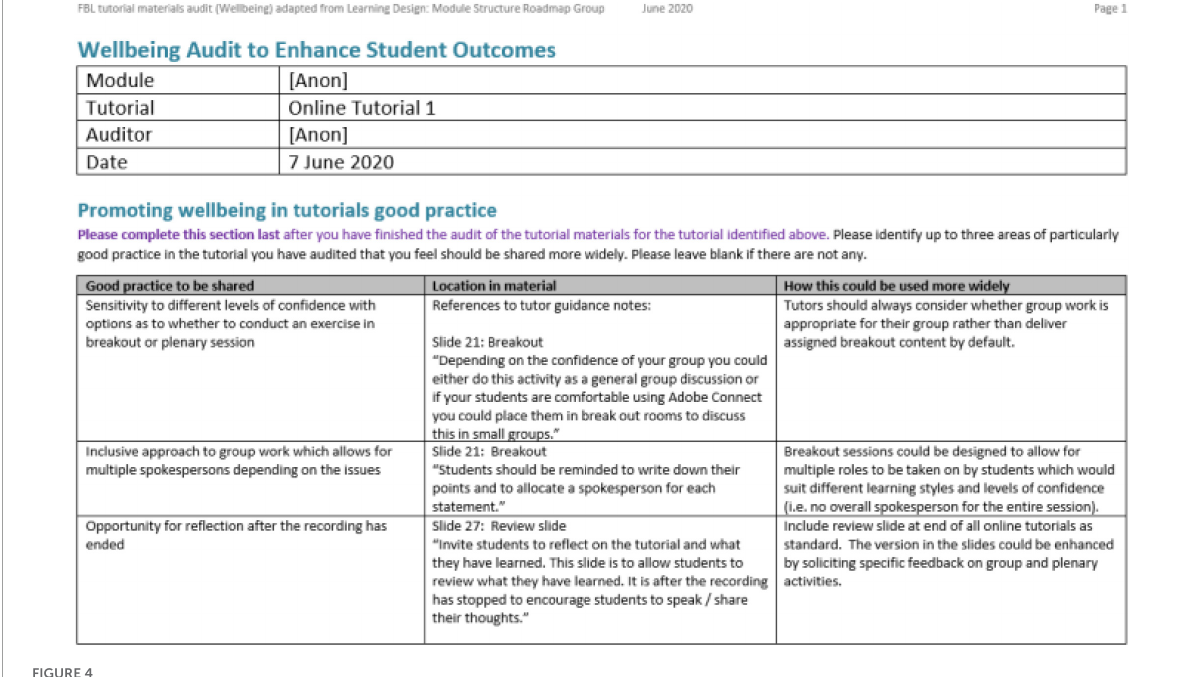
FIGURE4 Open University example of the first page of a completed mental wellbeing inclusivity